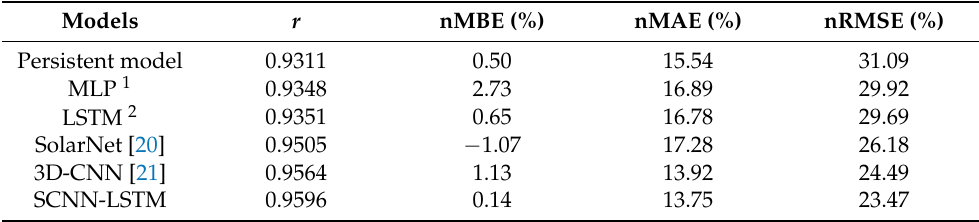
Table 5. The performance of different models for predicting the DNI 10-min in advance using the testing set.